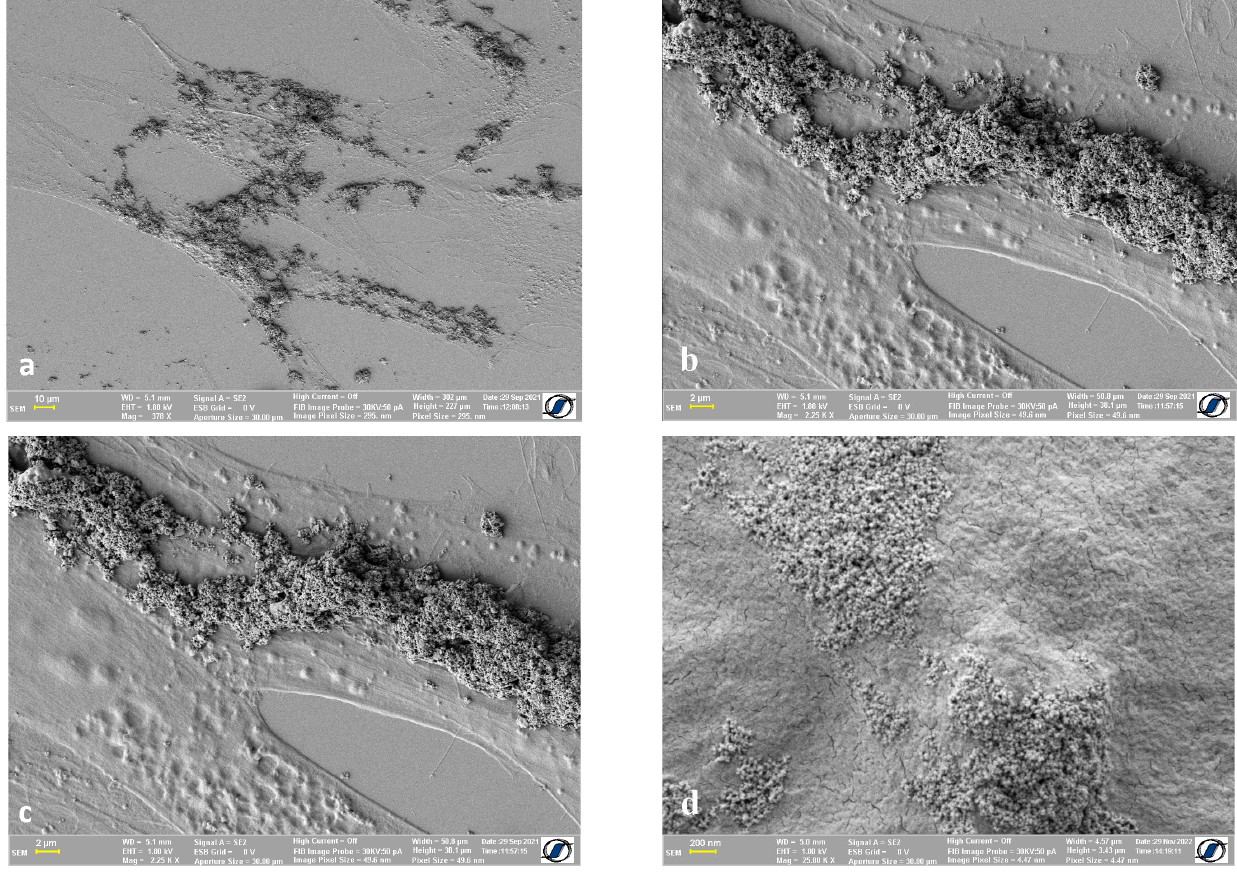
Figure 6. Adipose-derived mesenchymal stem cells with Fe-Cr-Nb-B magnetic nanoparticles: ( a ) clusters of magnetic particles on the cell membrane; ( b – d ) close-up of the magnetic particles adherent on the cell surface.